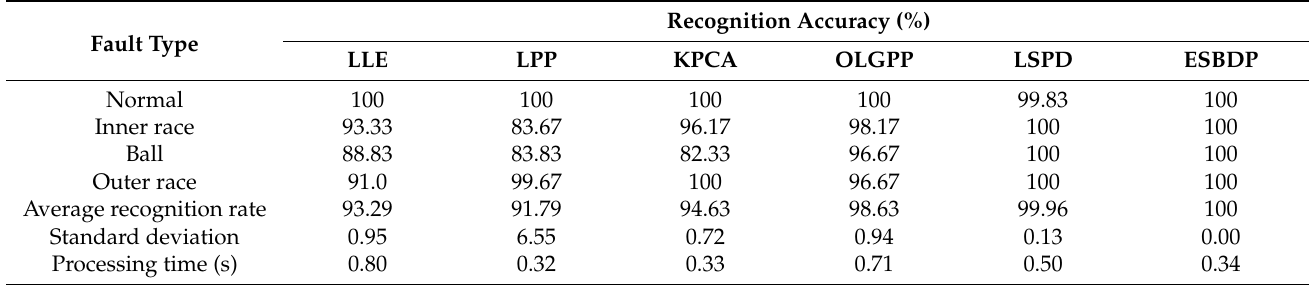
Table 3. Fault recognition rate of bearing dataset processed by different method.